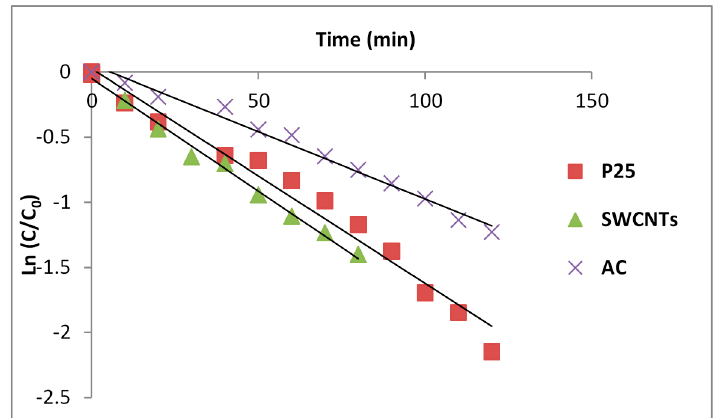
Figure 7. Kinetics of the total loss of SMX on irradiation of slurries in a 365-nm batch